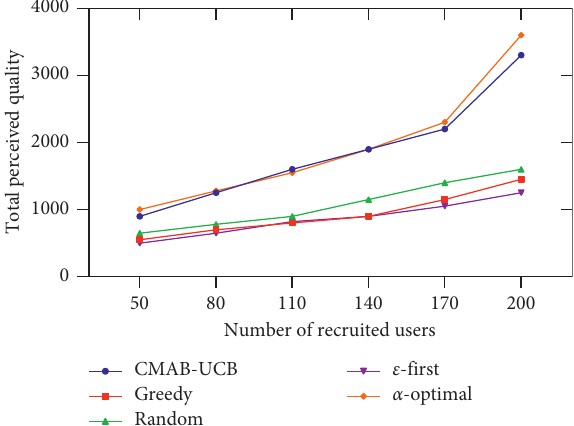
Figure 8: The relationship between perceived quality and the number of recruited users ( b � 15000).